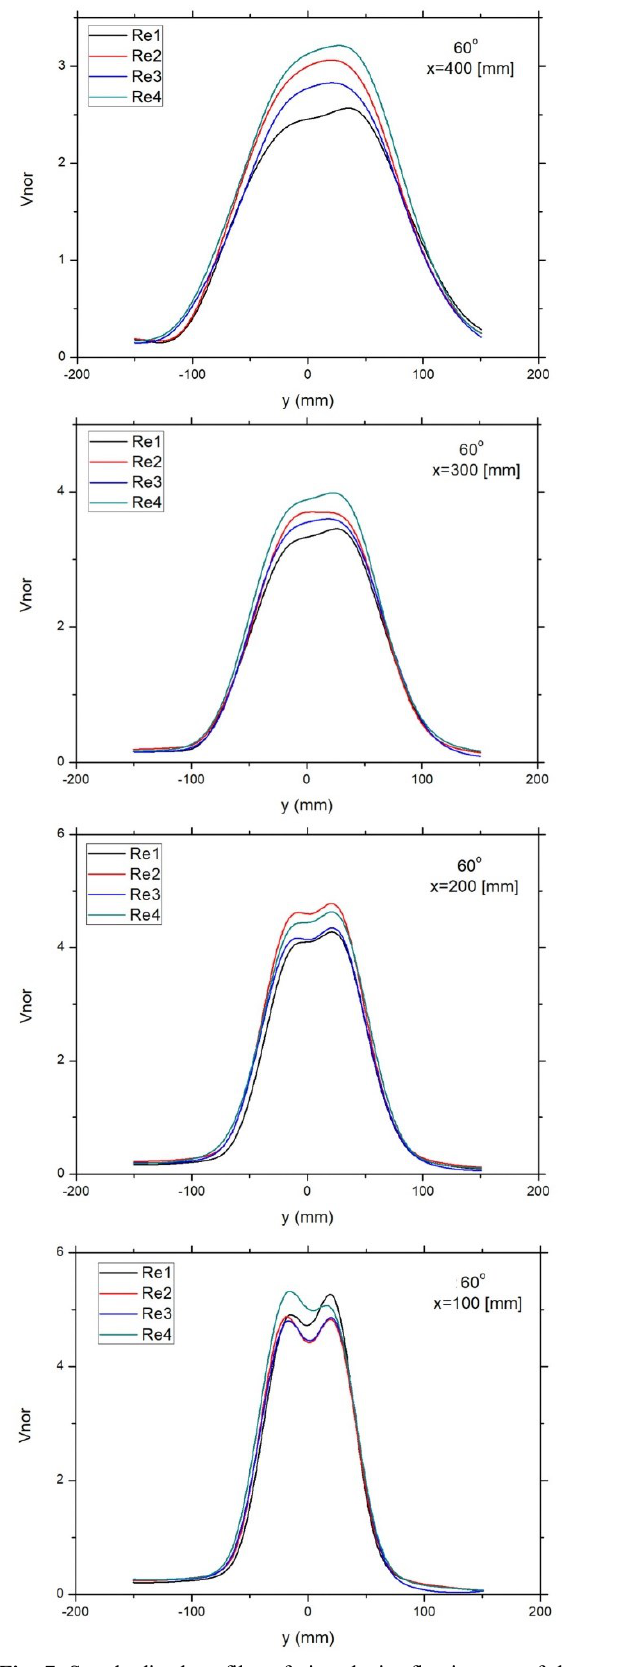
Fig. 7 . Standardized profiles of air velocity flowing out of the diffuser with vanes directed at an angle of 60° at different distances (x = 100 ÷ 400mm) from the outlet of the diffuser.